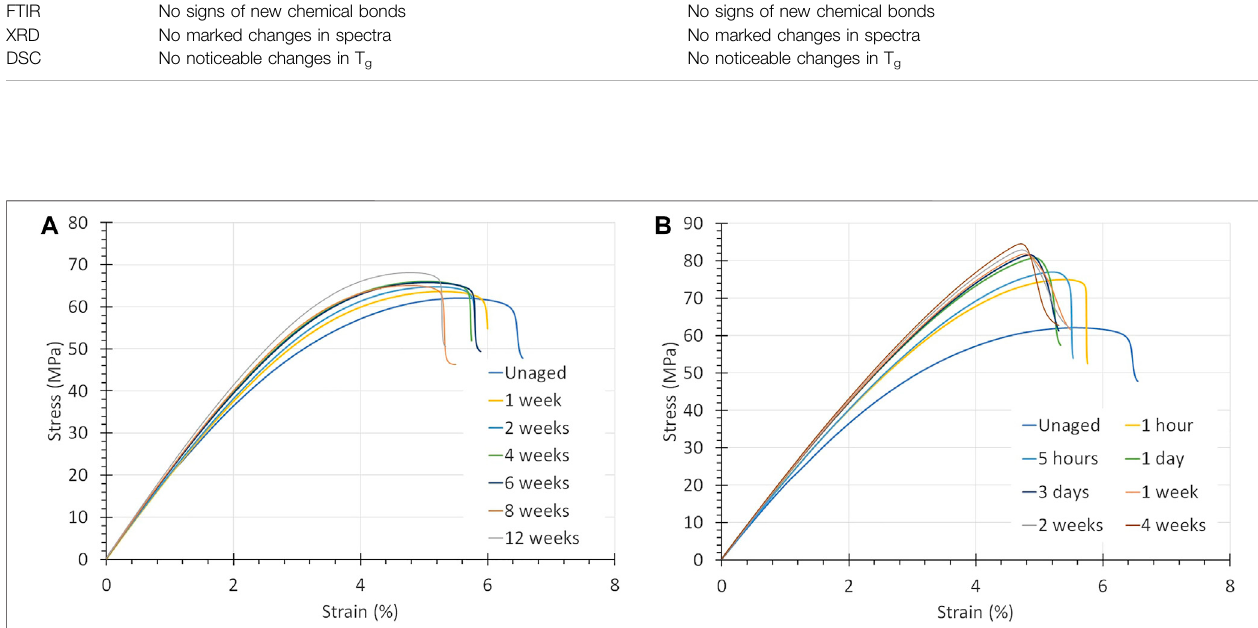
FIGURE8|(A) Stress-straincurvesofPSUexposedtopureO 2 at5 barand90 ° C.Thestraintoruptureisloweredtoanewlevel,whilethestrengthandE-modulus are enhanced. (B) Stress-strain curves of PSU exposed to air at 170 ° C, which is close to its T g of 185 ° C. The strain to rupture becomes less, whereas the strength and E-modulus increase.